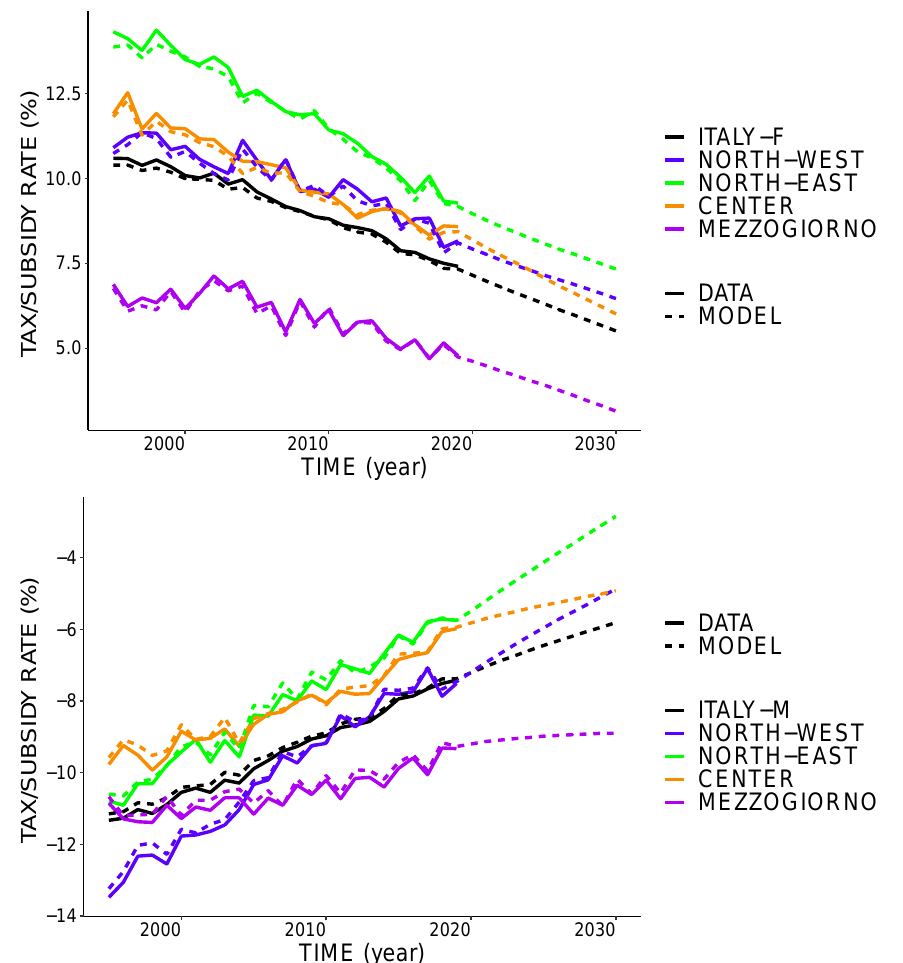
Figure 9. Projected tax/subsidy rates for Italian female ( top ) and male ( bottom ) population aged 65 from 2020 to 2030 across macroareas (NUTS-1 level). Source: author’s own elaboration on data from ISTAT